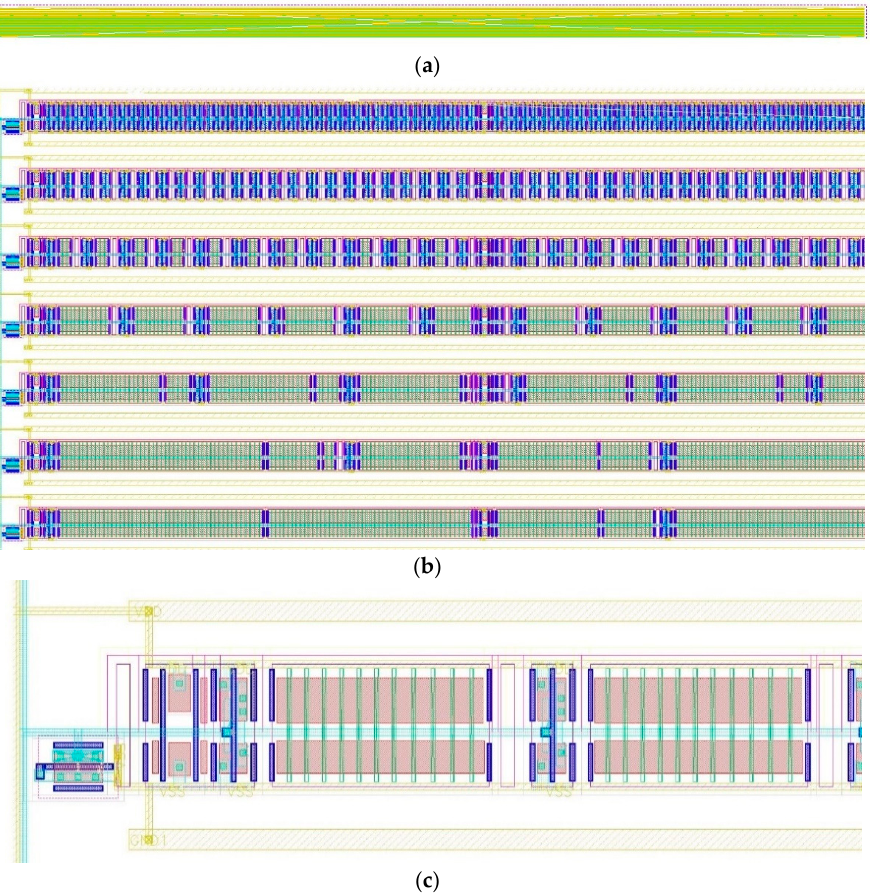
Figure 6. ( a ) Entire layout of the defined module (1004.46 μ m × 39.1 μ m dimensions); ( b ) zoomed in view for the first seven rows; ( c ) zoomed in view of two inverters